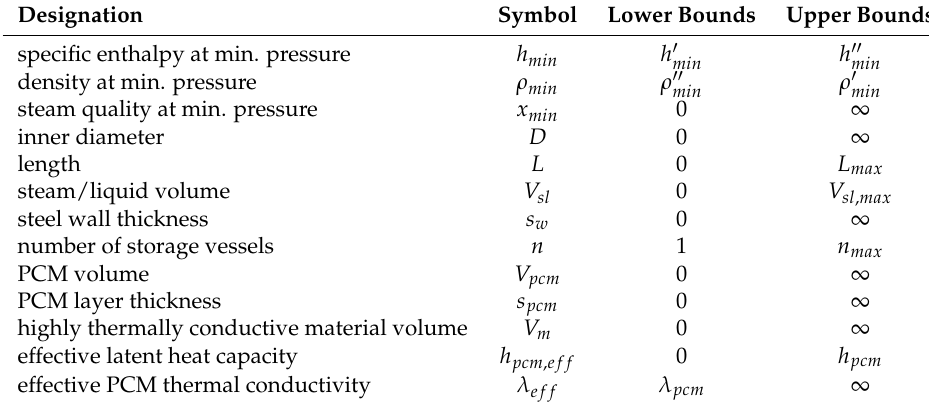
Table 1. Optimization variables with upper and lower bounds; h (cid:48) ... specific enthalpy of the liquid min phase at min. pressure, h (cid:48)(cid:48) ... specific enthalpy of the steam phase at min. pressure, ρ (cid:48) ... density of min min the liquid phase at min. pressure, ρ (cid:48)(cid:48) ... density of the steam phase at min. pressure, L max ... min